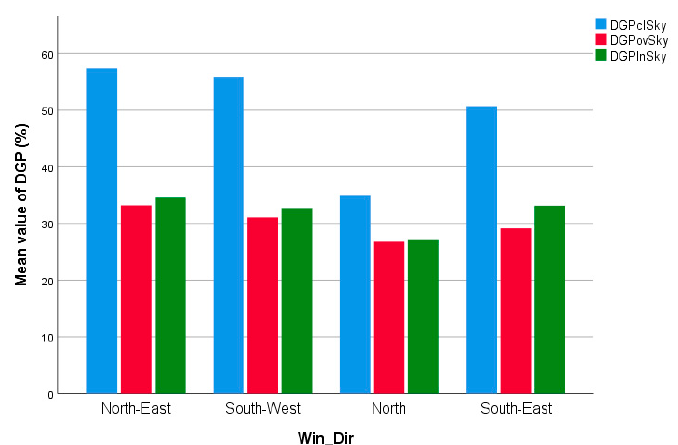
different sky conditions on 4 June at 10 a.m.